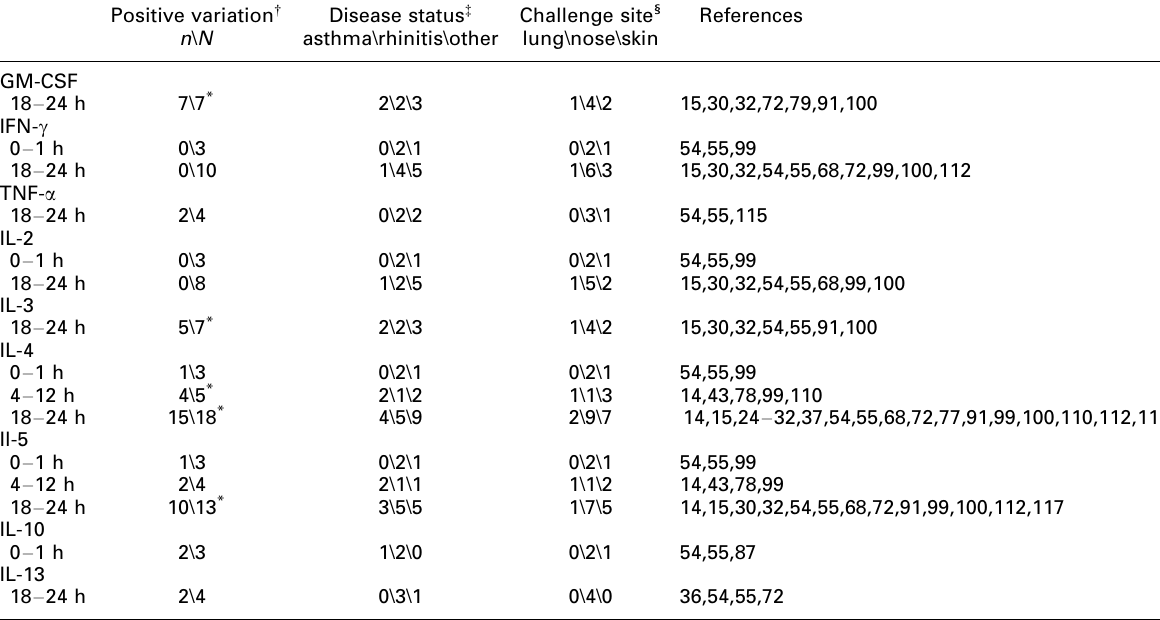
Table 2. Variation of cytokine mRNA expression in biopsies collected after allergen challenge in atopic patients. Positive variation